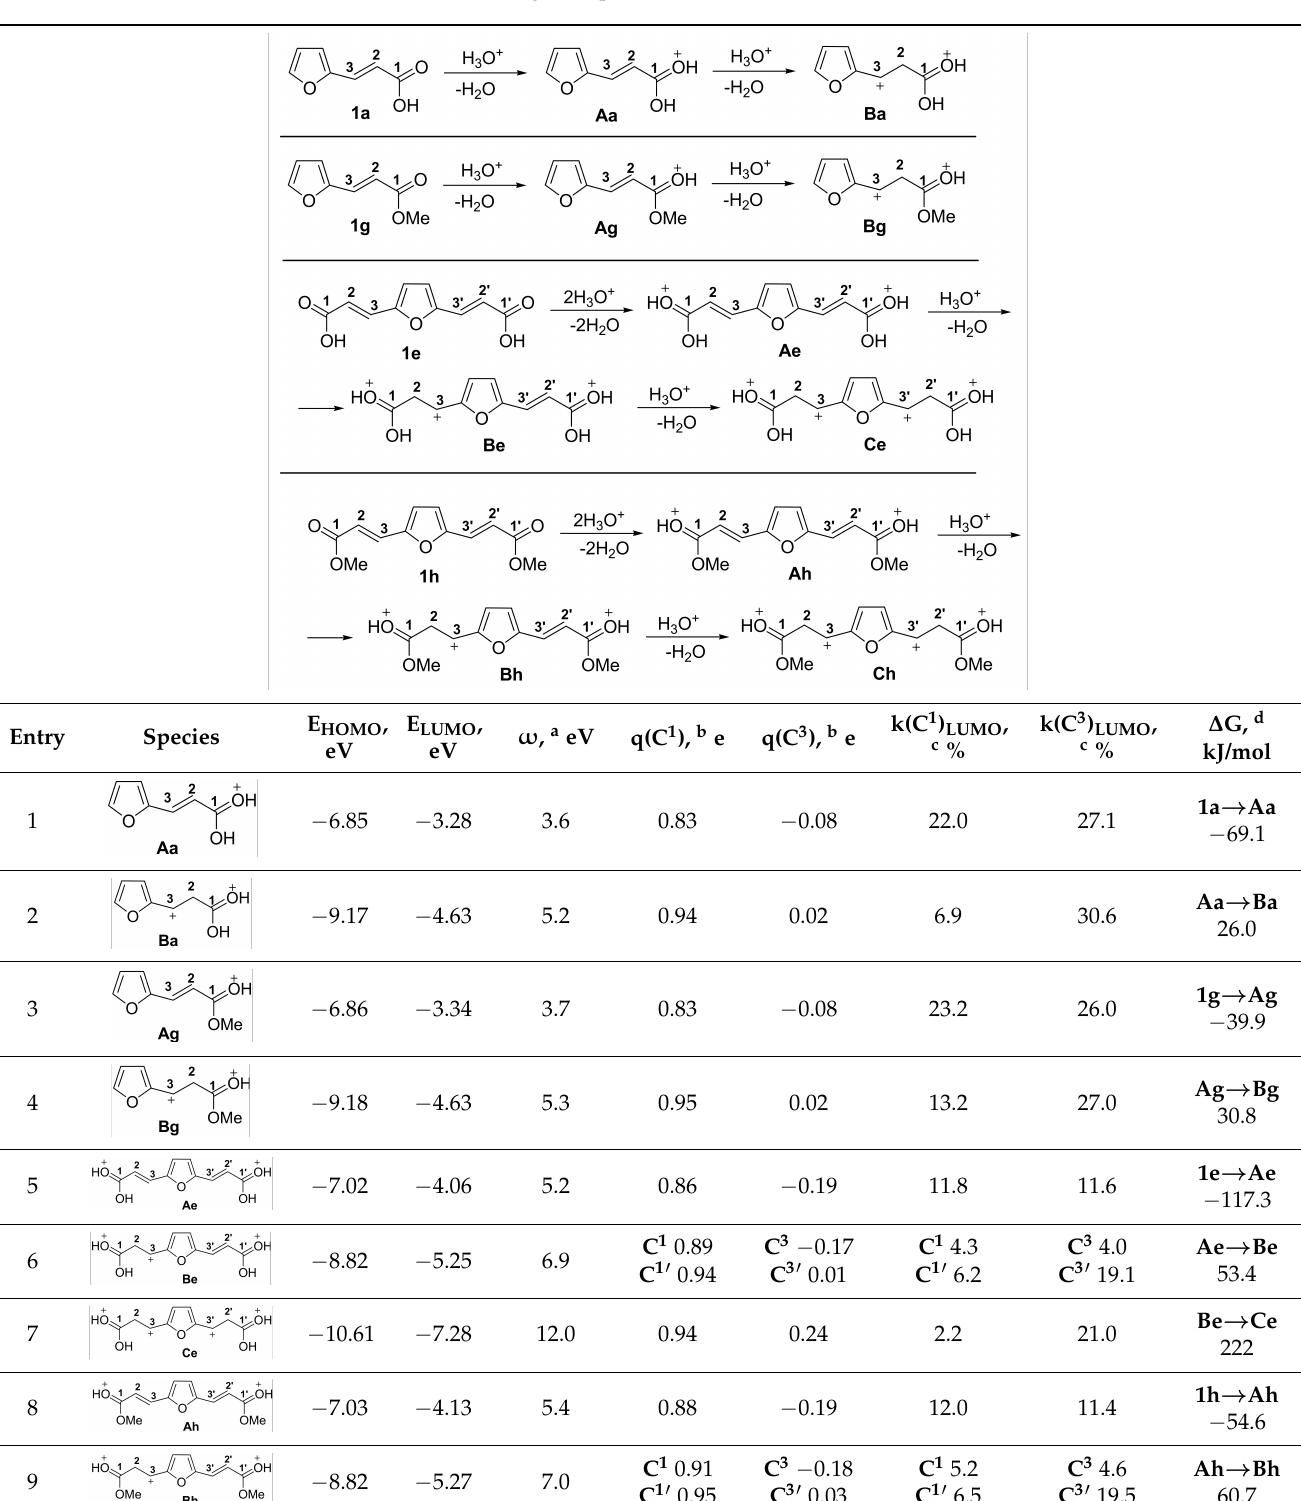
Table 5. Selected calculated (DFT) electronic characteristics of the protonated forms of furans, and values of Cribbs energies of protonation reactions ( ∆ G,